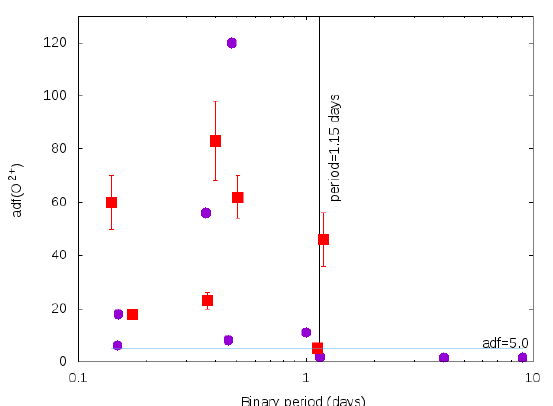
Figure 3. Abundance discrepancy for O 2 + plotted against binary period for the 15 objects where both are known: nine literature values (purple dots) and seven from this study (red squares). Also plotted is a point for the Necklace, which has a period of 1.16 days and an unmeasured abundance discrepancy, but with an upper limit reported to be low and plotted here as a factor of 3.0. A horizontal line indicates an adf of 5.0, which we consider the dividing line between “normal” and “elevated”, and a vertical line indicates the period of 1.15 days, which roughly divides objects with low and extreme adfs